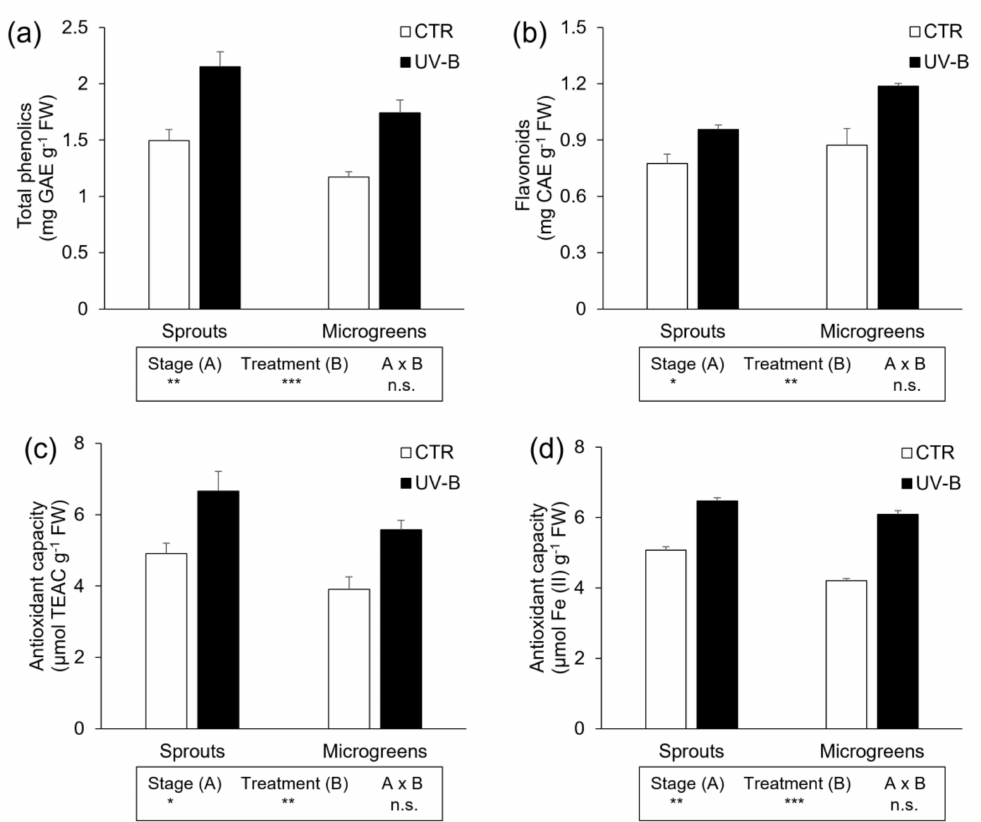
Figure 1. Determination of ( a ) total phenolics, ( b ) flavonoids, and antioxidant capacity measured through ( c ) ABTS and ( d ) FRAP assays of flaxseed sprouts and microgreens grown indoors under controlled conditions under PAR (CTR) or PAR + UV-B radiation (UV-B). Different letters indicate statistically significant differences, according to two-way ANOVA, followed by Tukey–Kramer post hoc test ( n = 6, p < 0.05). The results of two-way ANOVA are reported in the box below each histogram. Significance level: *** p ≤ 0.001; ** p ≤ 0.01; * p ≤ 0.05; n.s. = not